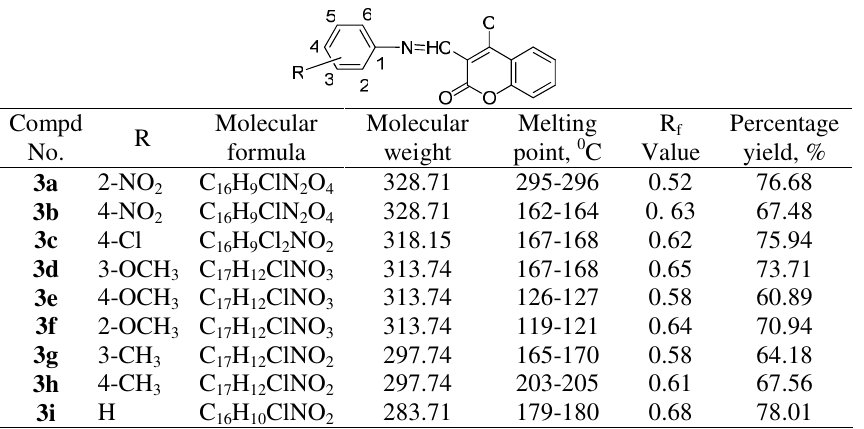
Table 1. Characterization data of compounds ( 3a-i